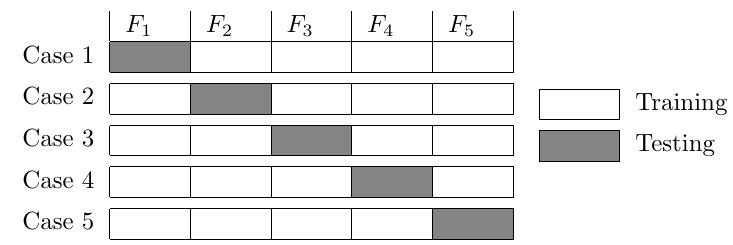
Figure 2. Graphical representation of the cross-validation procedure ( F 1 - Fold 1; F 2 - Fold 2; F 3 - Fold 3; F 4 - Fold 4; F 5 - Fold